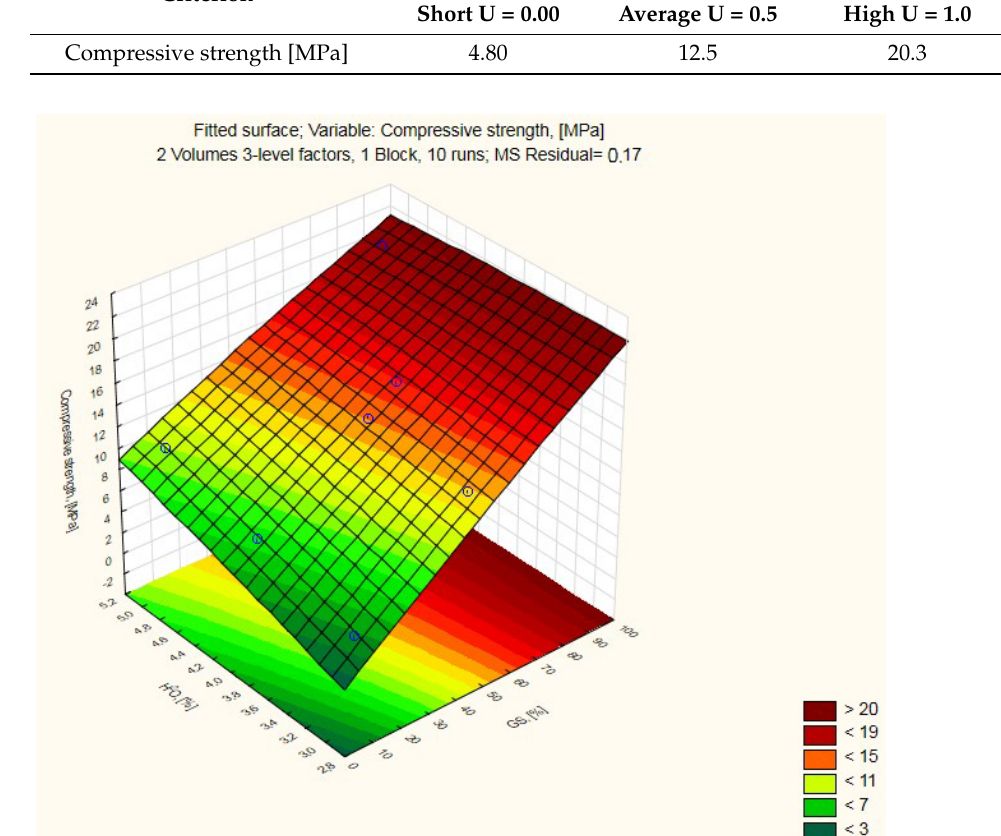
Figure 9. Graph of usability functions and their projection, with points of total usefulness (com ‐ pressive strength) of silicate products modified by glass sand (GS).